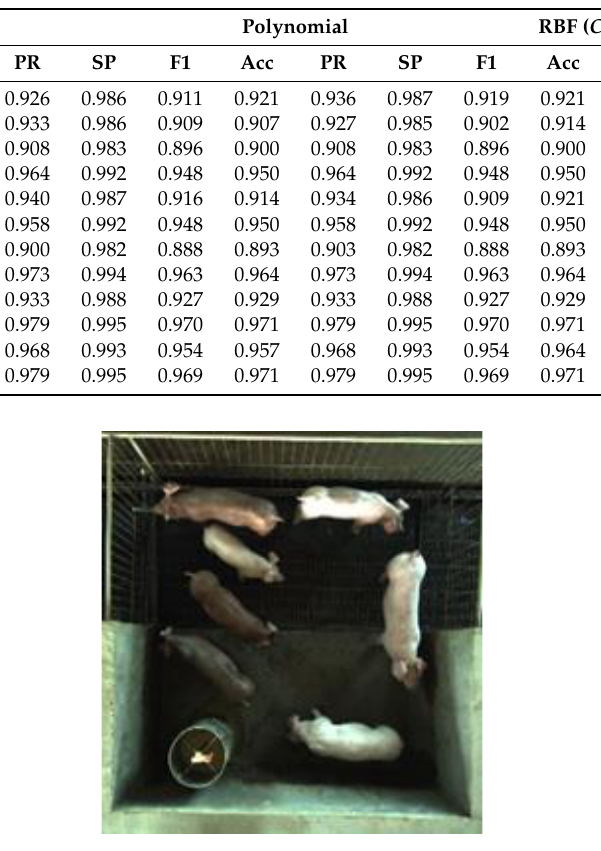
Figure 14. Video frame of dataset 1.